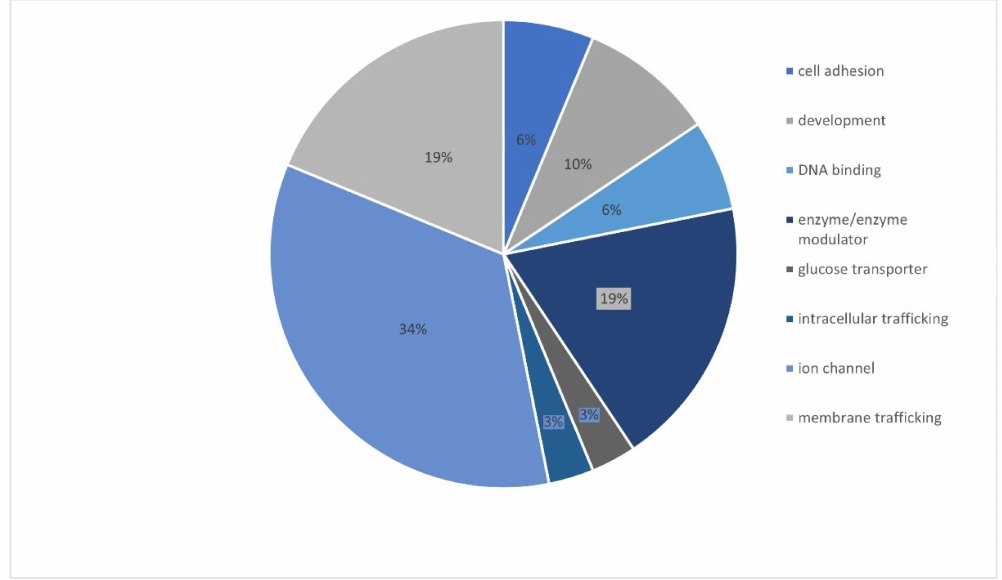
Figure 4. Functional classification of the mutated pathogenic or likely pathogenic